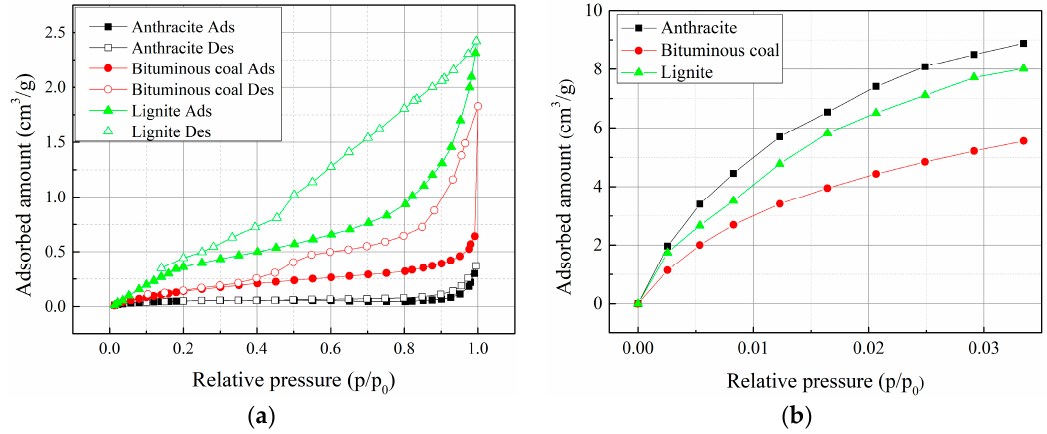
Figure 5. N 2 and CO 2 isotherms for the coal samples: ( a ) N 2 adsorption/desorption isotherms at 77 K; ( b ) CO 2 adsorption isotherms at 273 K. ( b ) CO 2 adsorption isotherms at 273